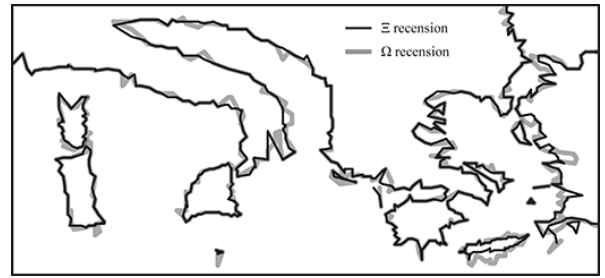
Figure 1. The outlines of the Mediterranean Sea according to the (cid:52) and (cid:127) recensions of Ptolemy’s Geography (Italy, the Balkans, and the Aegean Sea are taken as an example). This and all the other maps in the paper are drawn using the projection attributed by Ptolemy to Marinus of Tyre ( Geogr . 1.20.3–5), whom he introduces as his immediate predecessor and the primary source of information ( Geogr . 1.6.1). In modern terms, it is an equidistant cylindrical pro- jection, in which the ratio between equal latitudinal and longitudinal intervals is represented as 5 :